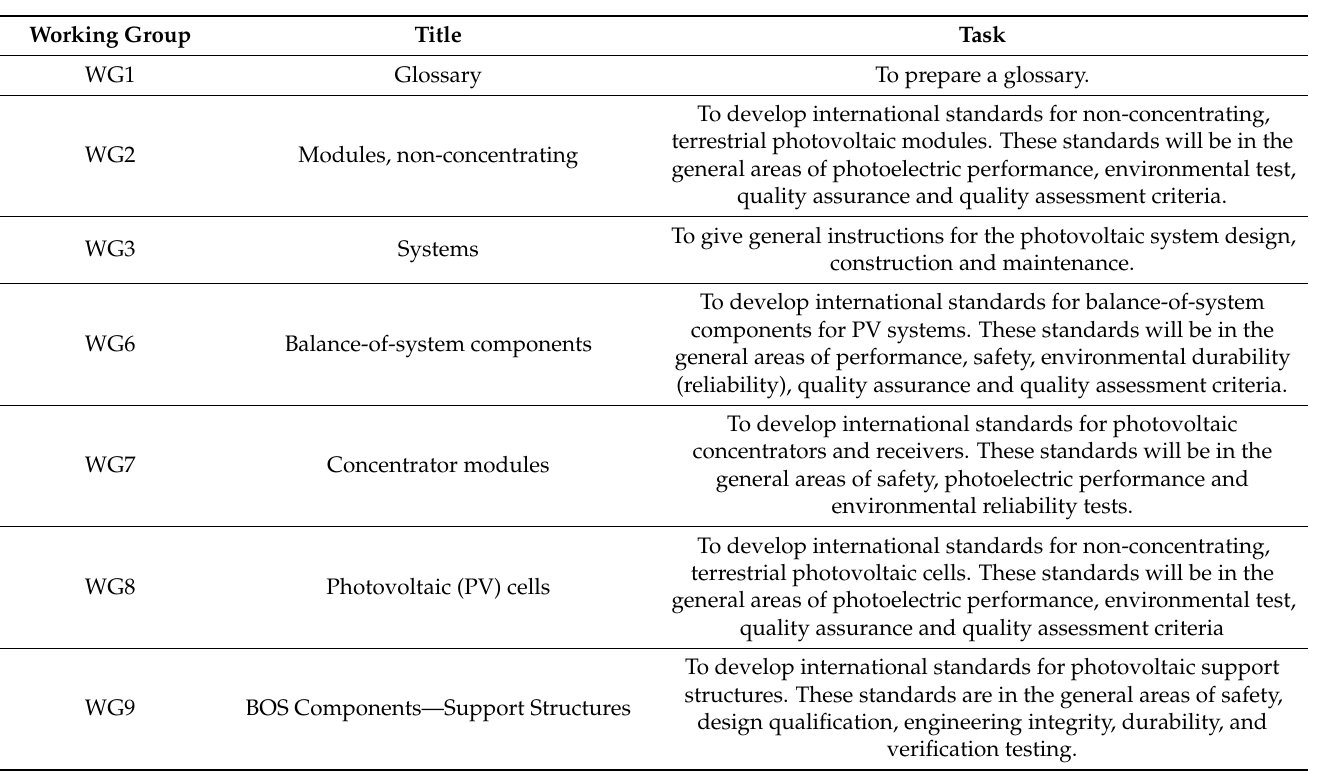
Figure 5. IEC/TC82 organization. Table 2. IEC/TC82 Working Groups and Tasks.